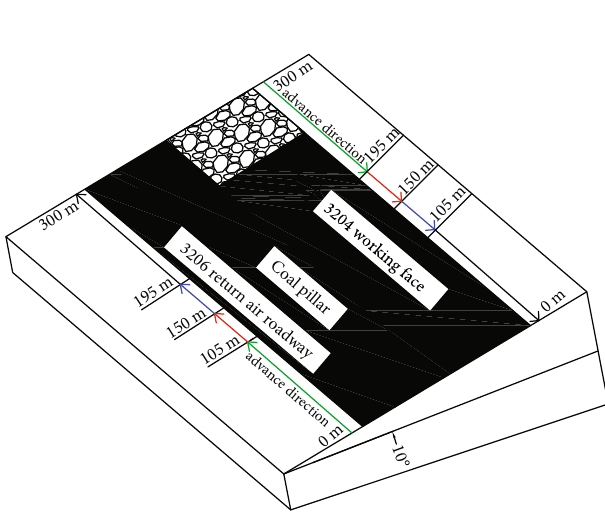
Figure 7: Schematic diagram of